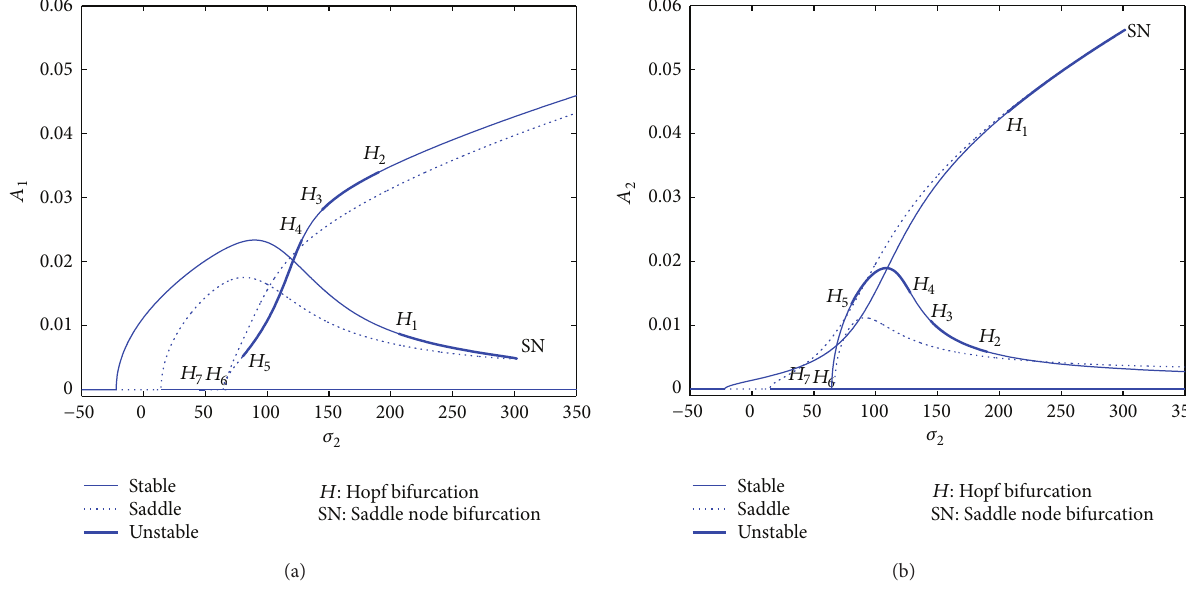
Figure 4: Frequency response curves for the (a) first mode and (b) second mode when the first mode is parametrically excited for the system parameters 𝜇 = 0.1 , 𝛼 = 0 , V 1 = 10 , V 𝑙 = 40 , and 𝜎 1 = 92.39